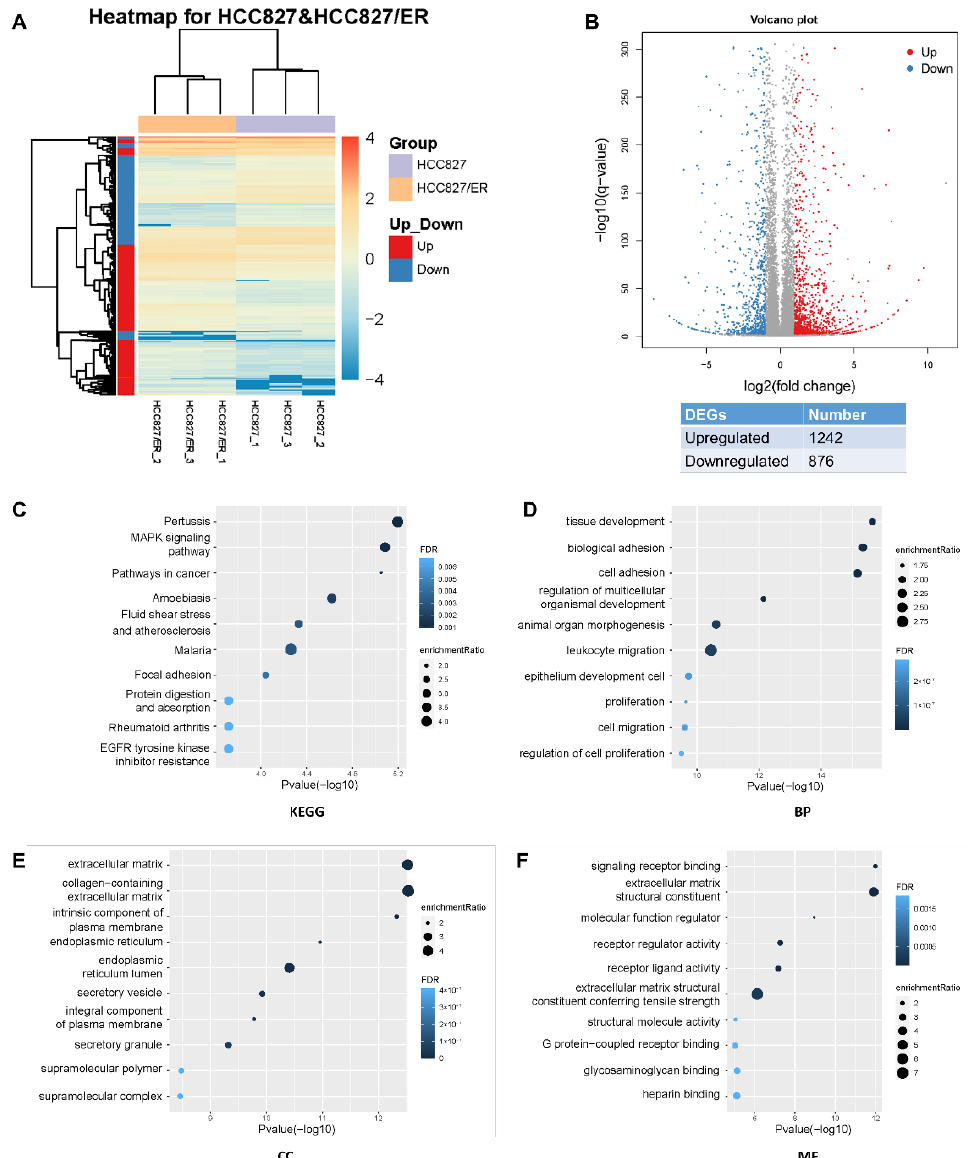
Figure 1. Profound changes in the global transcriptional landscape between parental and erlotinib- resistant cells. ( A ) Heatmap of genes that were differentially expressed (DEGs) between HCC827 and HCC827/ER cells. The color represents the level of transformed gene expression of log10. ( B ) Volcano plot displaying genes detected by RNA-Seq. Red points represent up-regulated DEGs (FoldChange ≥ 2, q value ≤ 0.001). Blue points represent down-regulated DEGs (FoldChange ≤ − 2, q value ≤ 0.001). Gray points represent non-DEGs. ( C ) KEGG pathway enrichment analysis of genes up-regulated or down-regulated in pairwise comparison of HCC827 and HCC827/ER cells. FDR ˂ 0.05 signified statistical significance. ( D ) Biological process, ( E ) cellular components, and ( F ) molec- ular function annotations of gene ontology were significantly enriched in genes that were differen- tially expressed between HCC827 and HCC827/ER cells. Top 10 terms of each class were performed. FDR ˂ 0.05 signified statistical significance.